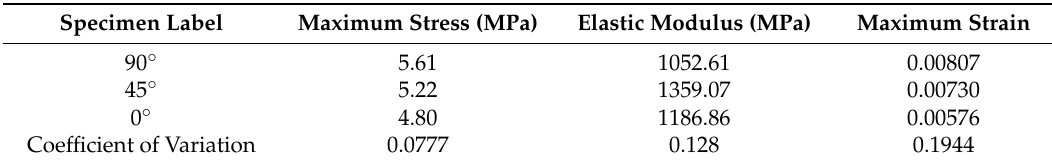
Table 1. Summary of tensile test results for samples at three different angles.